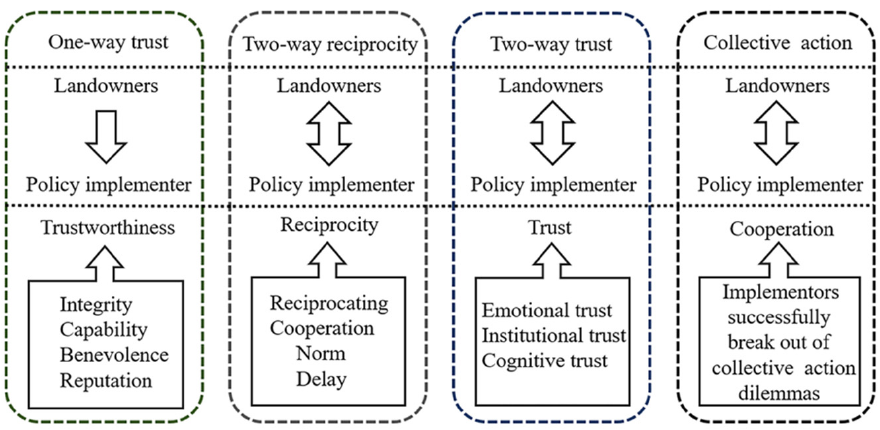
Figure 3. The relational dimension of social capital.